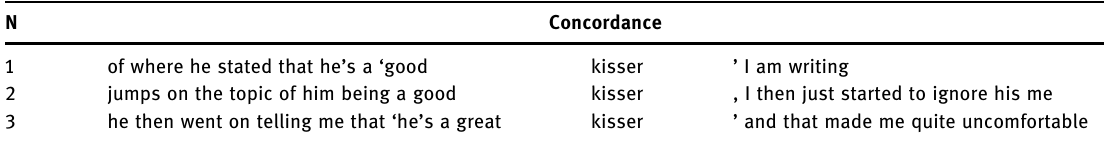
Table 11: Concordance lines for